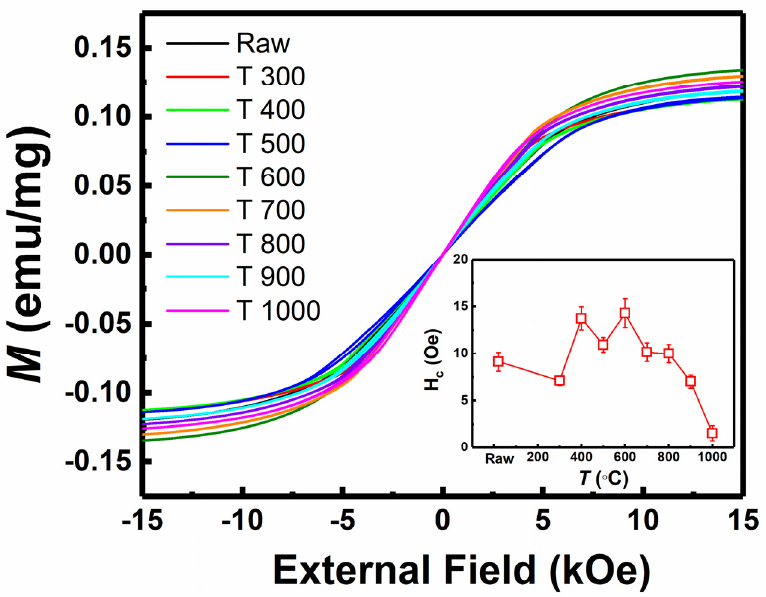
Figure 1. M-H loops of Invar alloy wires with various heat treatment conditions (raw, T300, T400, T500, T600, T700, T800, T900, T1000), respectively. And H c as a function of heat treatment temperature ( T ) extracted from M–H loops is shown in the inset.